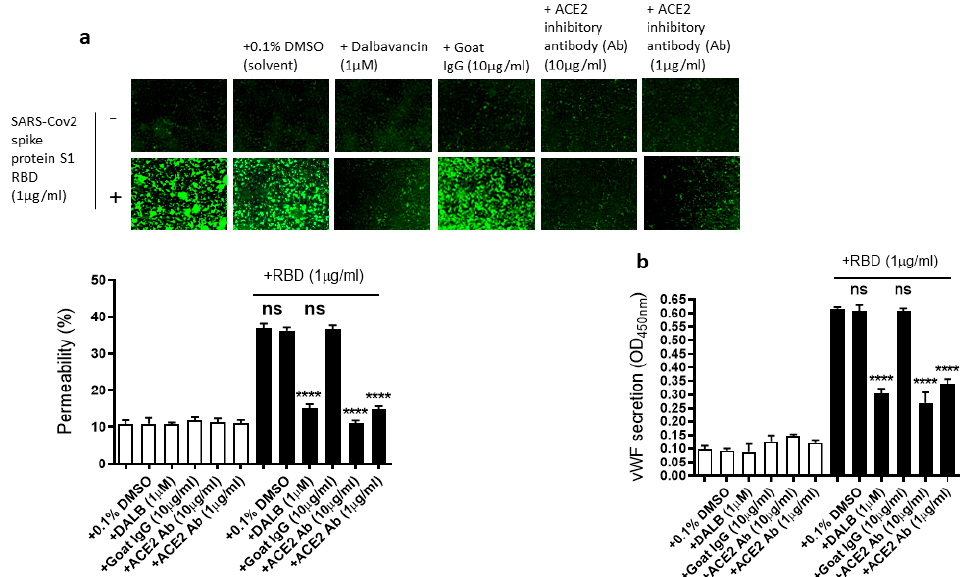
Figure 5. Effect of dalbavancin and the ACE2 inhibitory antibody on SARS-CoV-2 spike protein S1 RBD-induced EA.hy 296 cell monolayer permeability and its vWF secretion. EA.hy 296 cell monolayer pre-incubated without or with DMSO (0.1%), dalbavancin (1 µM), or goat IgG (10 µg/mL), or ACE2 inhibitory goat IgG (1 or 10 µg/mL) for 30–60 min were treated without or with 1 µg/mL SARS-CoV-2 spike S1 RBD for 72 h. ( a ) Visualization at 10× magnification of the RBD-induced EC permeability inhibition by dalbavancin and the ACE2 inhibitory antibody. ( lower panel ) Represents the quantification data of ( a ). ( b ) Inhibition of the RBD-induced vWF secretion from EA.hy 296 cells by dalbavancin or the ACE2 inhibitory antibody. Statistical significance was measured by one-way ANOVA comparing the treated group with the untreated control group (**** p < 0.0001. ns, not significant).